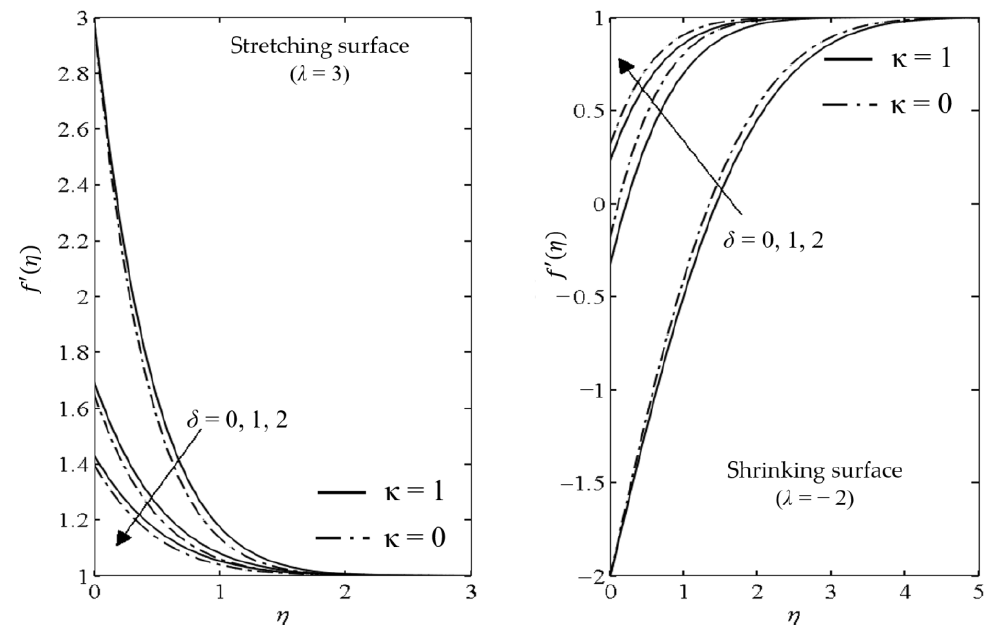
Figure 10. Effect of the velocity slip parameter, δ , on the velocity profiles for different parameters κ and λ .